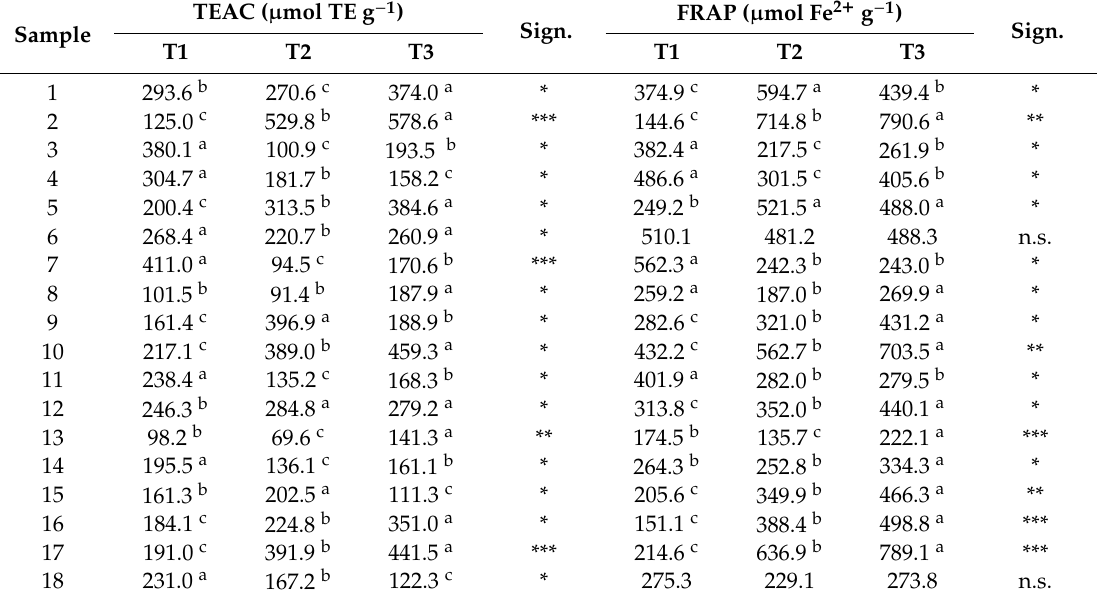
Table 5. Results of Trolox Equivalent Antioxidant Capacity (TEAC) and the Ferric Reducing Antioxidant Power (FRAP) assays on the Criollo cocoa samples after fermentation and drying (T1) and after roasting (T2, 120 ◦ C for 22 min; T3, 135 ◦ C for 15 min). The data are expressed as mean of triplicate